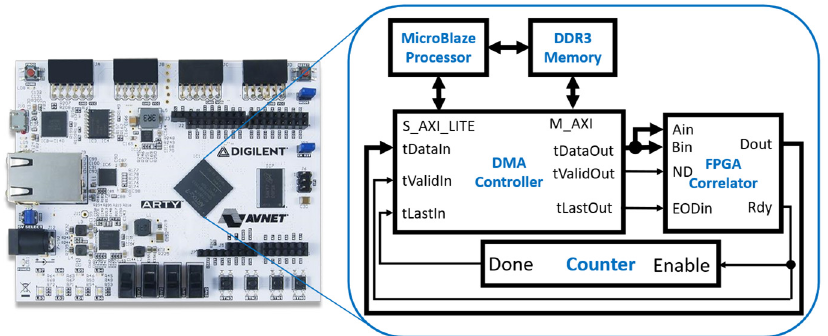
Figure 11. The test bench includes the MicroBlaze processor and the FPGA correlator, which can be configured with either the linear or multi-tau correlator. The DMA controller has a write channel to send data to the correlator and a read channel to receive the data from the correlator. The test bench was implemented on the Arty A7 board.